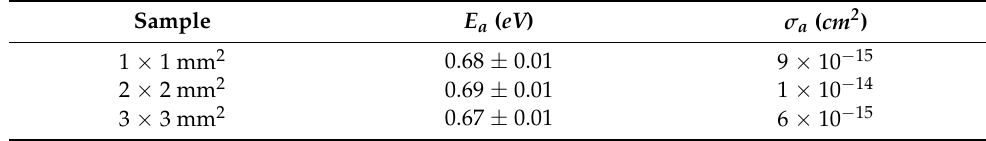
Figure 5. Shows a comparison of ( a ) DLTS spectra of the 4H-SiC detector with active surface area of 1 × 1 mm 2 before and after radiation tests. Measurements settings were: reverse voltage − 10 V, pulse bias − 0.1 V, pulse width 10 ms, and emission rate 50 s − 1 . Table 2. Z 1/2 deep level parameters obtained from DLTS spectra of 4H-SiC detectors after radiation tests: activation energy, E a , and effective carrier capture cross section, σ a